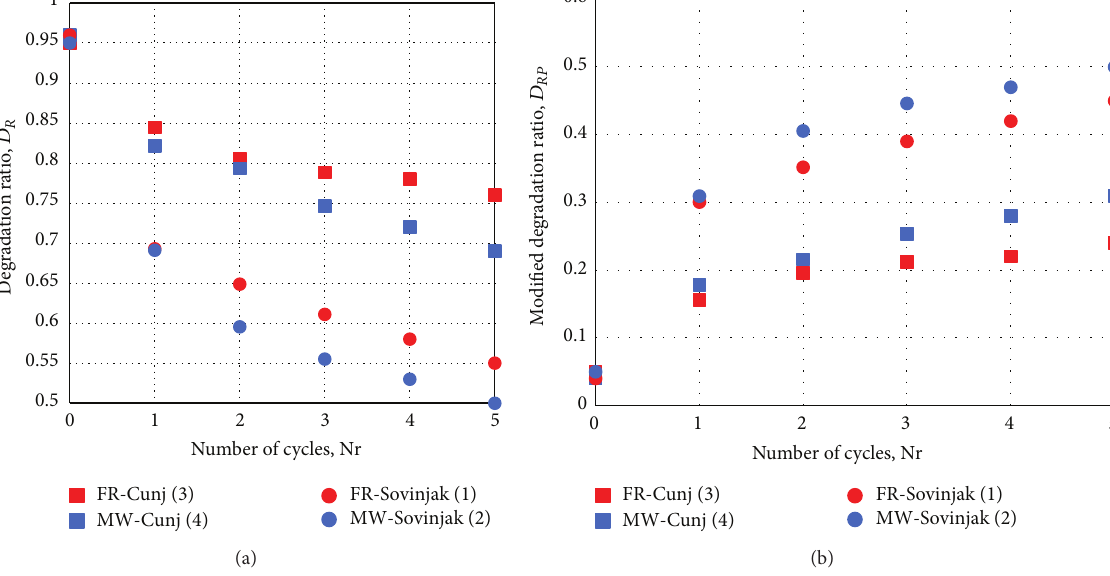
Figure 11: (a) Degradation ratio and (b) modified degradation ratio after each slaking cycle for the siltstone samples of weathering grades I (FR) and III (MW) from flysch outcrops near Cunj Village and Sovinjak